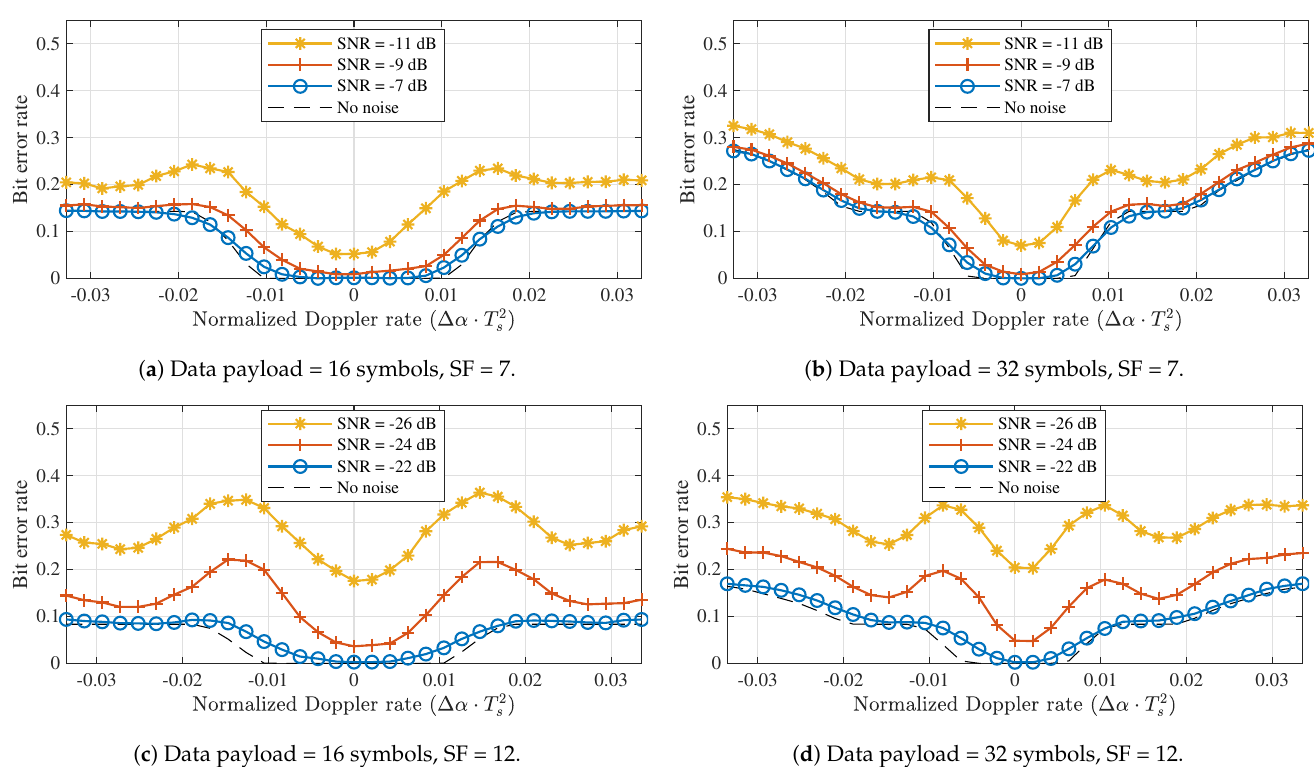
( c ) Data payload = 16 symbols, SF = 12. ( d ) Data payload = 32 symbols, SF = 12. Figure 8. Bit error performance impact of constant Doppler rates for different data payload sizes and spreading factors ( B = 125kHz).